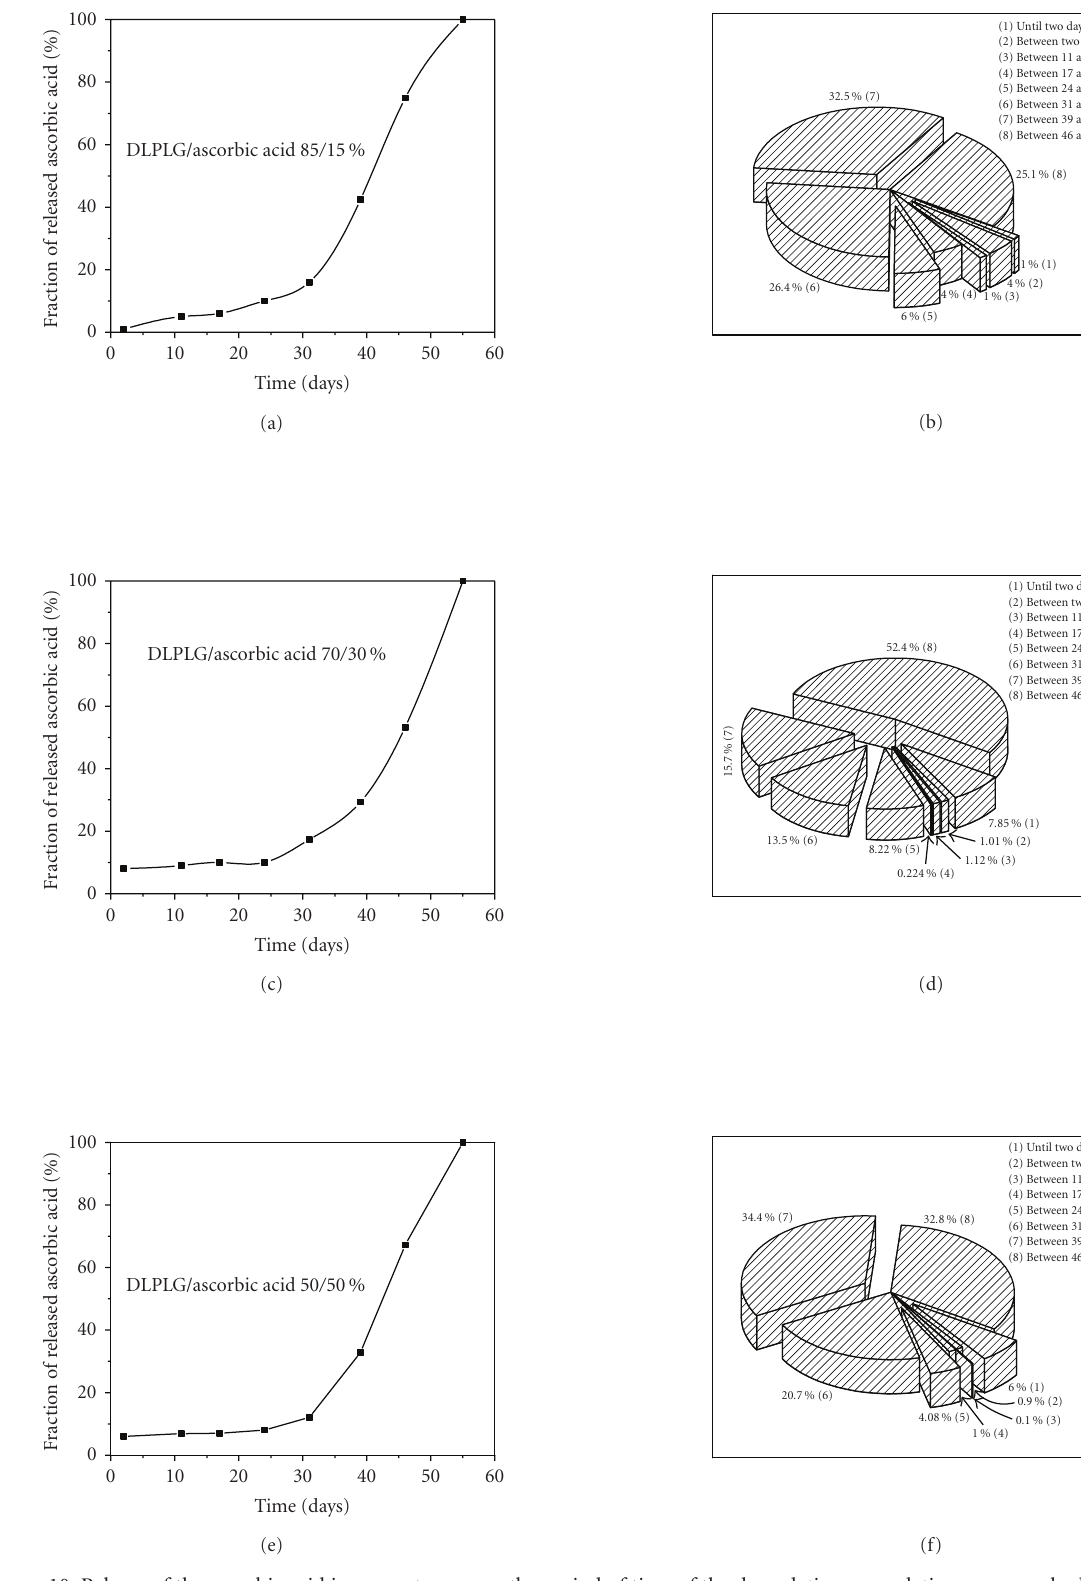
Figure 10: Release of the ascorbic acid in percentages over the period of time of the degradation: cumulative curves and relative review for (a)-(b) DLPLG/ascorbic acid 85/15%; (c)-(d) DLPLG/ascorbic acid 70/30% and (e)-(f) DLPLG/ascorbic acid 50/50% (relative review on figures (b)-(d)-(f): until two days (1), between two and 11 days (2), between 11 and 17 days (3), between 17 and 24 days (4), between 24 and 31 days (5), between 31 and 39 days (6), between 39 and 46 days (7), between 46 and 55 days